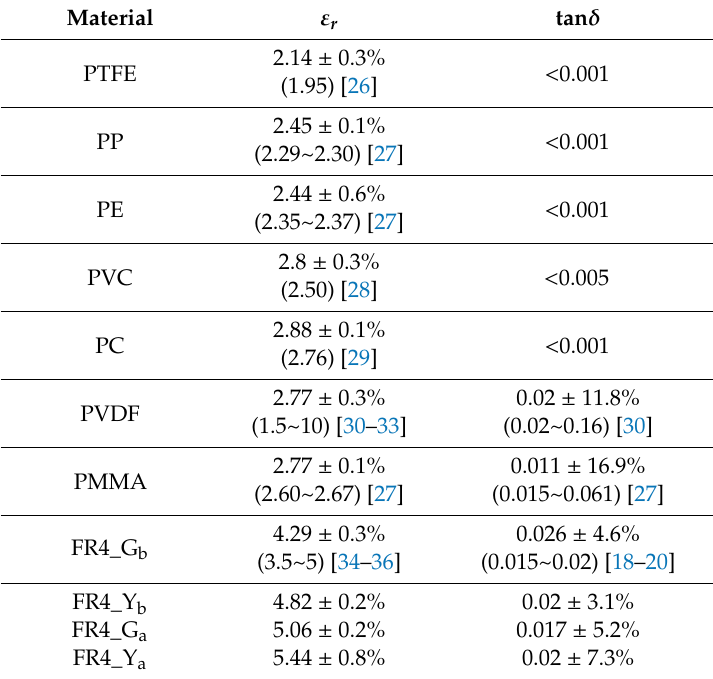
Table 1. The dielectric properties of the plastics at 36